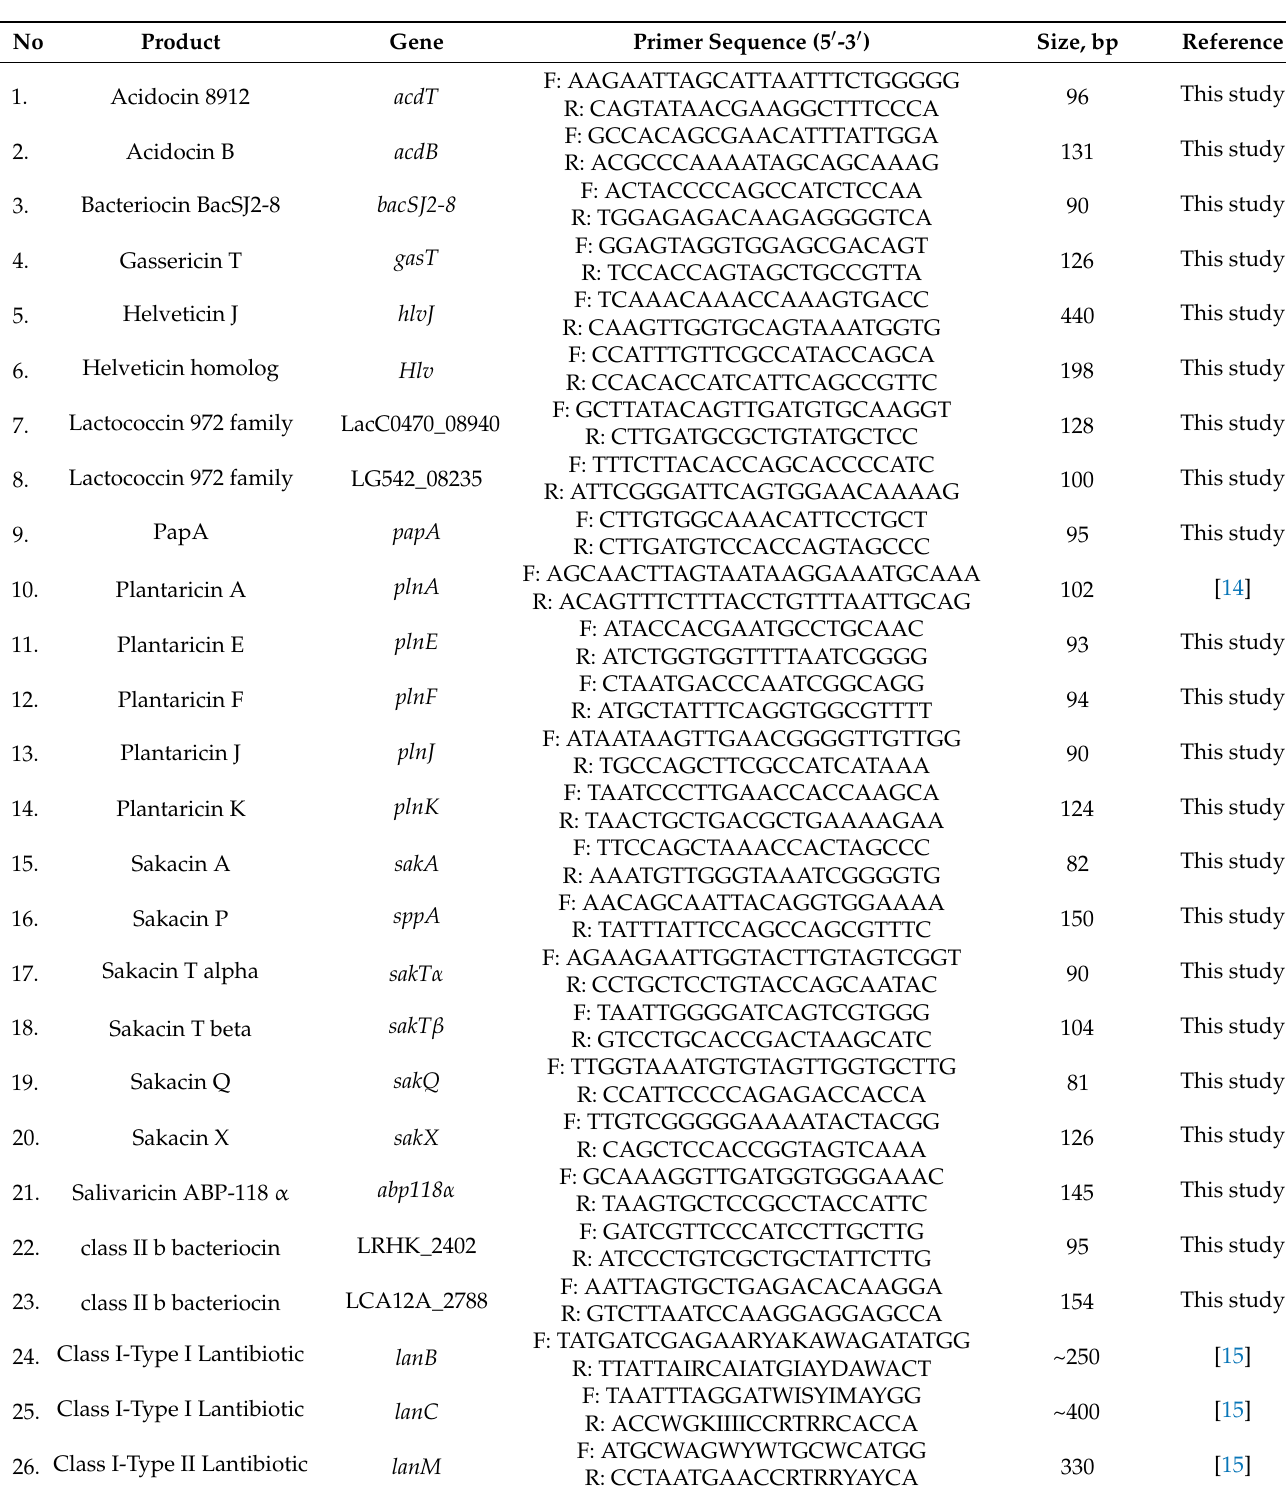
Table 2. Primers used in bacteriocin structure genes